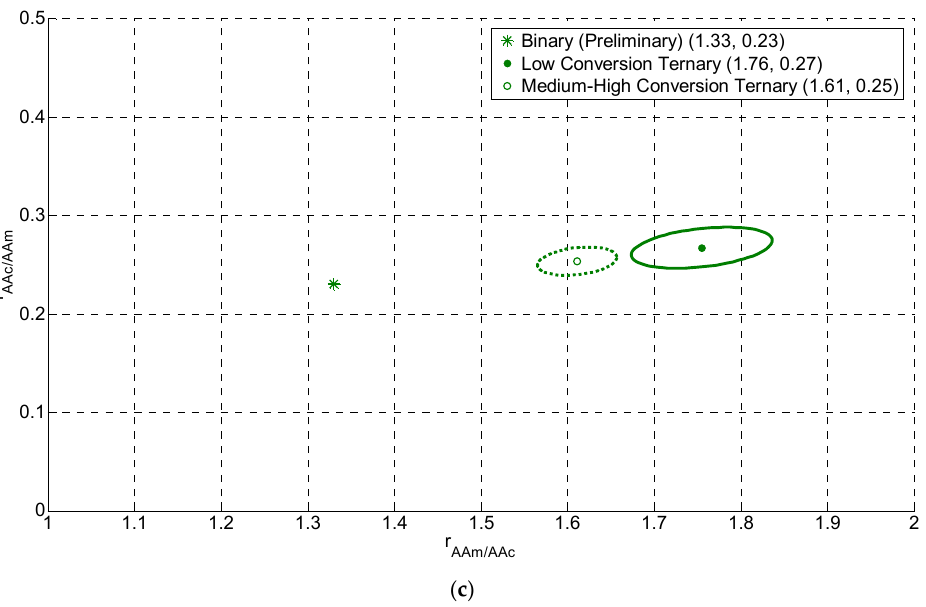
Figure 3. Reactivity ratio estimation results for AMPS/AAm/AAc terpolymerization (with preliminary copolymerization estimates from literature [12,14]).